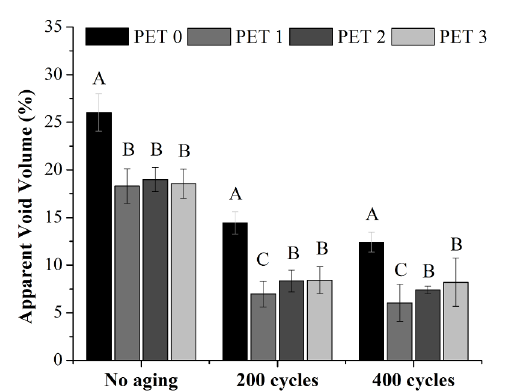
Figure 3. Average and standard deviation values of apparent porosity of fiber-cement produced with PET particles. Consecutive means of the same letter do not statistically differ by the Scott-Knott mean test, at 5% of significance. PET1= 20 to 24 mesh, PET2= 24 to 32 mesh and PET3 = 32 to 35